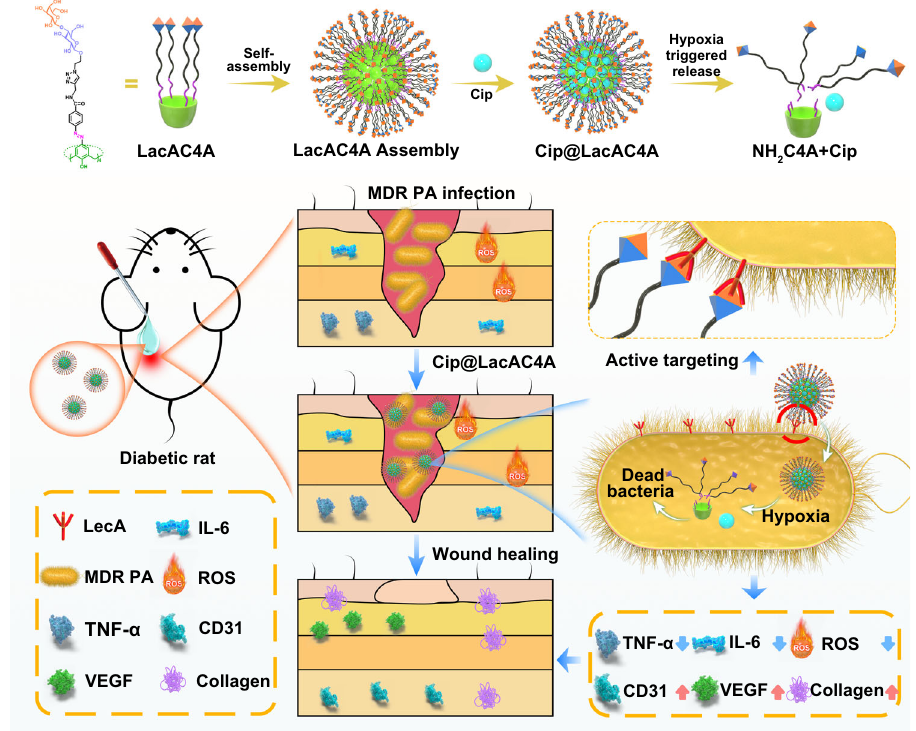
Fig. 1 | Schematic design of the hypoxia-responsive drug delivery system. The supramolecular formulation Cip@LacAC4A can actively target the MDR PA infecting diabetic rat wound via the interactions of lactose and the surface glyco- proteins of bacteria. Then azo groups respond quickly under hypoxic condition,